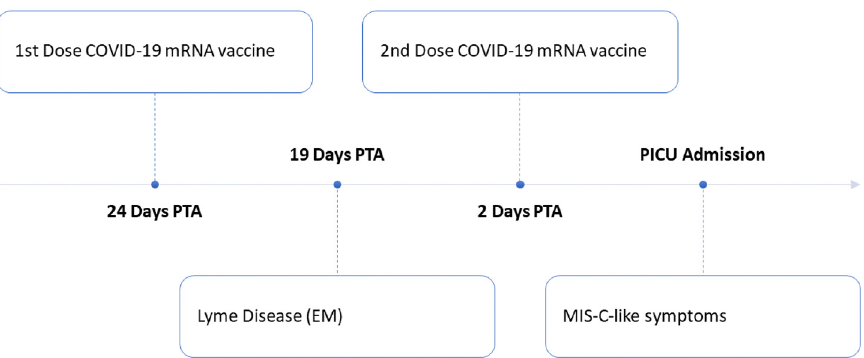
Figure 1. Timeline of development of MIS-C-like symptoms after Lyme disease and COVID-19 mRNA vaccination. Abbreviations: EM, erythema migrans; PICU, pediatric intensive care unit; PTA, prior to admission.